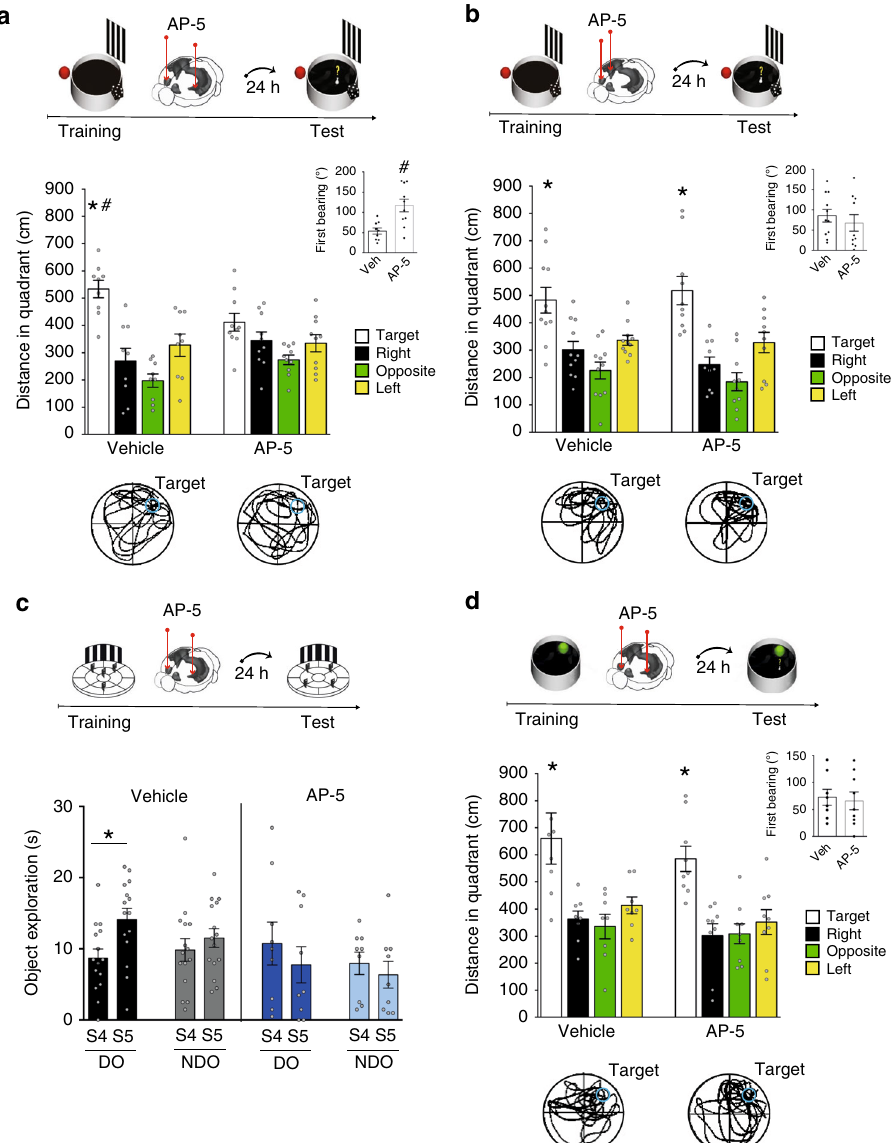
Fig. 2 vSUB – VS pathway disconnection impairs spatial memory consolidation. a Immediate post-training functional disconnection between the vSUB and the VS with AP-5 ( n = 10), impaired spatial memory consolidation compared to vehicle controls ( n = 9) (two-way ANOVA of quadrant preference F 3,51 = 15.824; p = 0.0001; treatment F 1,17 = 0.270; p = 0.6100; quadrant × treatment F 3,51 = 4.104; p = 0.0110). The insert shows fi rst bearing of mice in the two groups ( t 17 = 3.450; p = 0.0031; unpaired t -test). Bottom panels: representative path from vehicle and AP-5 animals. b Unilateral post-training AP-5 ( n = 10) administrations in the vSUB and in the ipsilateral VS did not impair mice ability to locate the platform compared to vehicle-injected mice ( n = 11) (two- way ANOVA of quadrant preference F 3,57 = 20.775, p = 0.0001; treatment F 1,19 = 1.077, p = 0.3124; quadrant preference × treatment F 3,57 = 0.499, p = 0.6846). The insert shows fi rst bearing of mice in the two groups ( t 19 = 0.709; p = 0.4871; unpaired t -test). Bottom panels: representative path